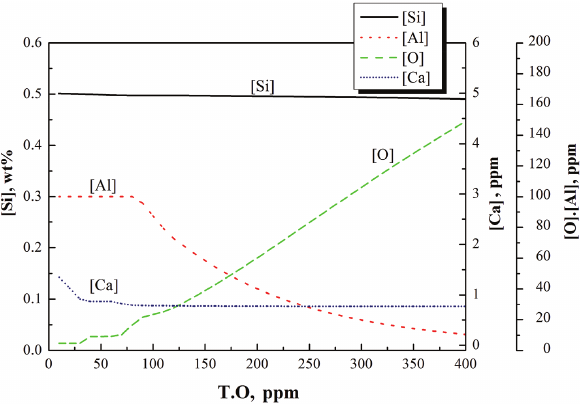
Figure 5: Effect of total oxygen on the equilibrium content of